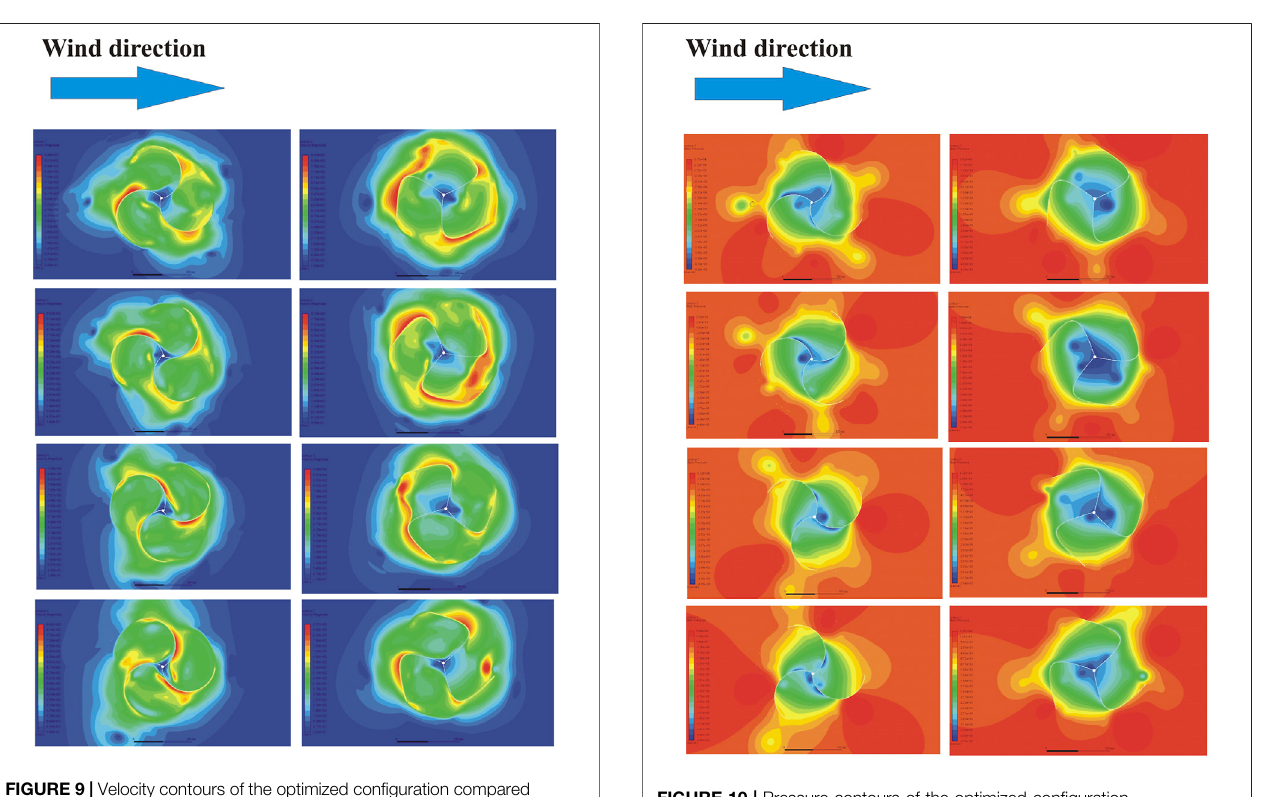
FIGURE 10 | Pressure contours of the optimized con fi guration compared to the original